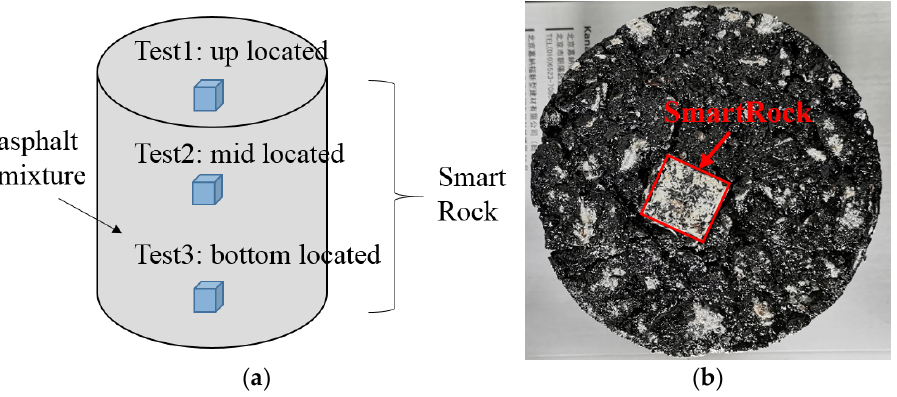
Figure 4. SmartRocks in SCG specimen: ( a ) test loaction; ( b ) after